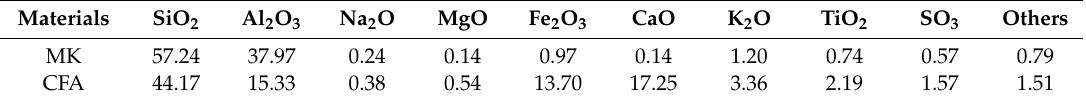
Table 1. Chemical compositions of MK and CFA